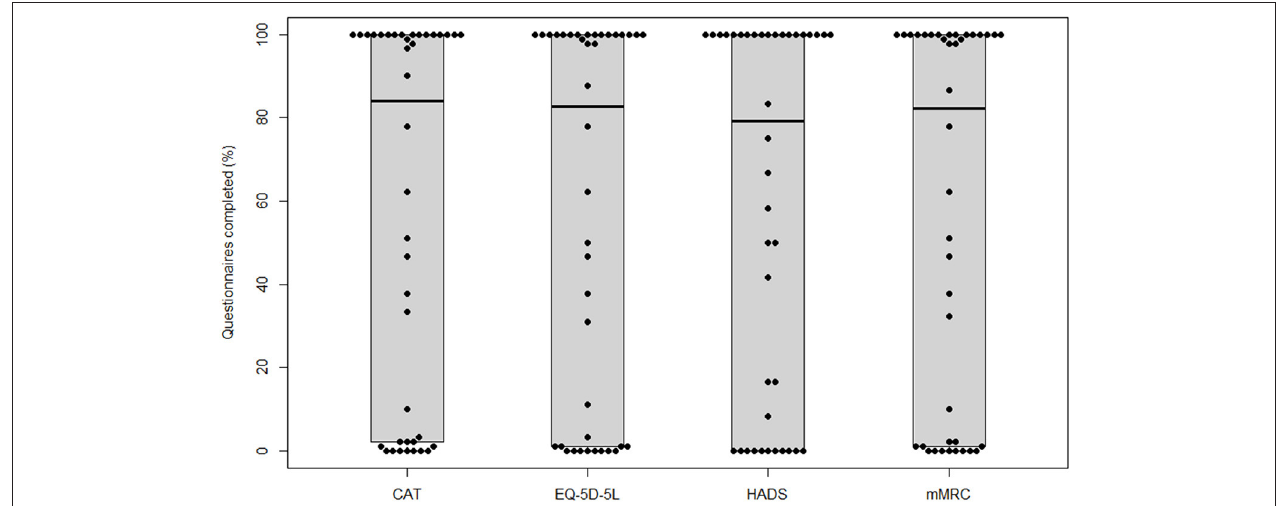
FIGURE 2 | Adherence for each questionnaire. CAT, COPD Assessment Test; EQ-5D-5L, European Quality of Life − 5 Dimensions − 5 Levels Instrument; HADS, Hospital Anxiety and Depression Scale; mMRC, modified Medical Research